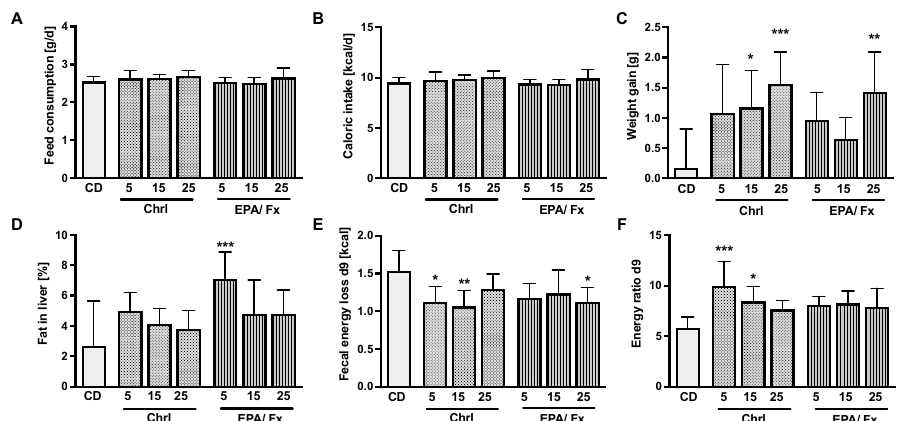
Figure 1. Daily feed ( A ) and caloric intake ( B ) of C57BL/6J mice, body weight gain within 14 days ( C ), and the percentage of liver fat content at day 14 ( D ). The fecal energy loss on day 9 was measured with a calorimeter ( E ), and the energy ratio of day 9 was calculated by dividing the feed intake on day 9 by the fecal energy loss on day 9 ( F ) of C57BL/6J mice. Concentration values are expressed as mean ± SD from n = 8 samples per group. Diets supplemented with concentrations of 5%, 15%, and 25%. Statistics: * indicates differences relative to CD. * p < 0.05, ** p < 0.01, *** p < 0.001. Abbreviations: CD, control diet; EPA, eicosapentaenoic acid; Fx, fucoxanthin; Chrl, diet with chrysolaminarin-rich PT; EPA/Fx, diet with EPA- and Fx-rich microalgae PT; d, day.